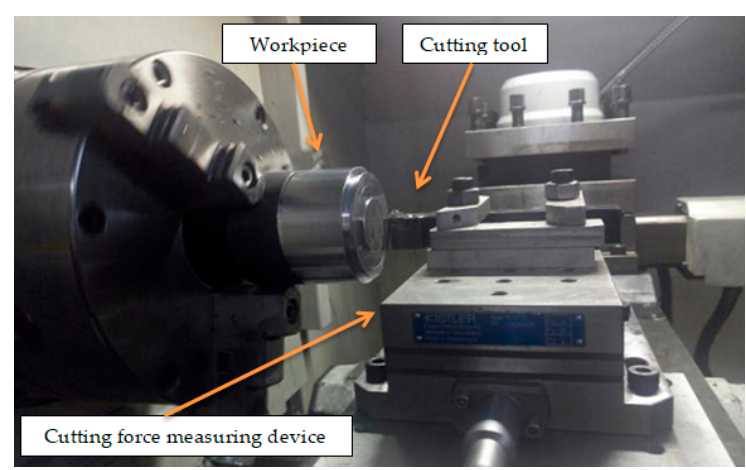
Figure 12. Actual turning diagram.